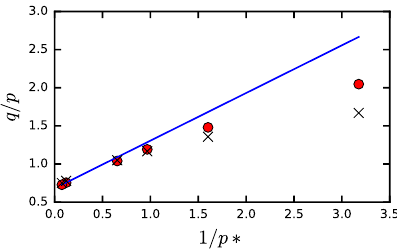
Figure 6. Ratio q / p versus 1 / p ⇤ at critical state. Straight line: Mohr-coulomb fit to large p ⇤ data, using ' value of cohesionless case. Red dots: numerical results. Crosses: predictions of Eq.